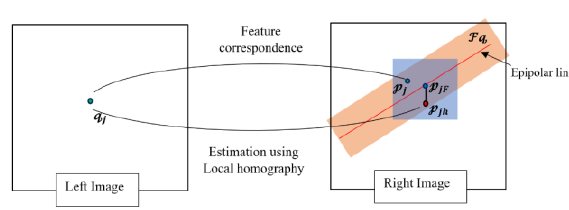
Figure 4: Using the local homography and epipolar projection to estimate the corresponding feature’s location.